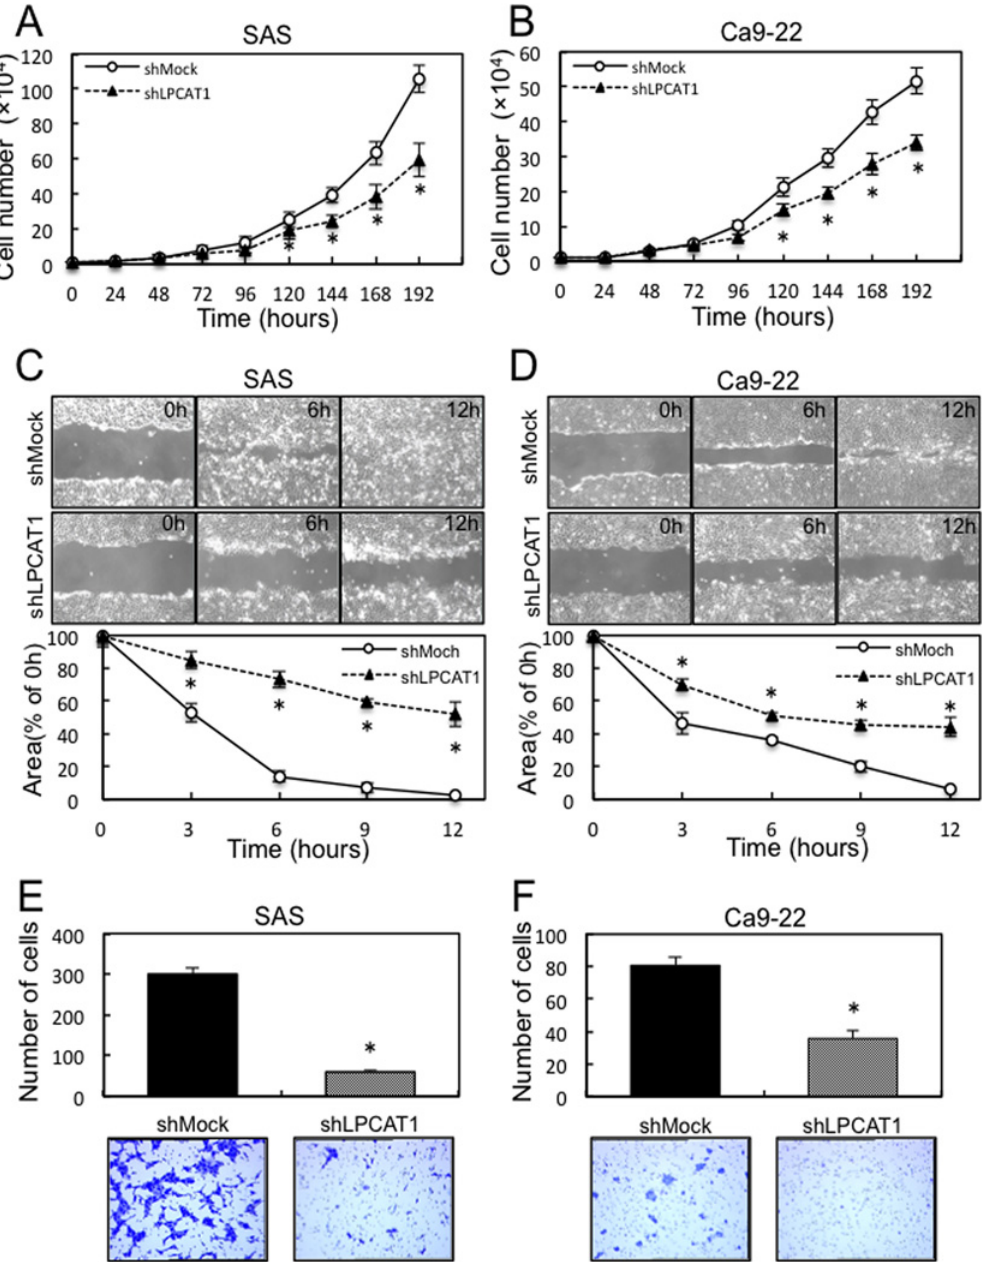
Fig 3. Effect of LPCAT1 knockdown on OSCC-derived cell lines. ( A, B ) Proliferation assay of shMock- and shLPCAT1-transfected cells (SAS- and Ca9 – 22-derived transfectants). To determine the effect of shLPCAT1 on cellular proliferation, shLPCAT1- and shMock-transfected cells were seeded in 6-cm dishes at a density of 1×10 4 viable cells/well. Both transfected cells were counted on seven consecutive days. The cellular growth of shLPCAT1-transfected cells (SAS- and Ca9 – 22- derived transfectants) is inhibited significantly compared with the shMock-transfected cells after 5 days (120 hours). The results are expressed as the mean ± SEM of values from three assays. The asterisks indicate significant ( * p < 0.05, Mann-Whitney U test) differences between the shLPCAT1- and shMock-transfected cells. ( C, D ) Migration assay of shMock- and shLPCAT1-transfected cells (SAS- and Ca9 – 22-derived transfectants). To evaluate the effect of LPCAT1 knockdown on migration, uniform wounds were made in confluent culture of the shLPCAT1- and shMock-transfected cells (SAS- and Ca9 – 22-derived transfectants) and the extent of closure was monitored visually every 3 hours for 24 hours. The mean value was calculated from data obtained from three separate chambers. The wound area was decreased significantly ( * p < 0.05, Mann-Whitney U test) in the culture of shMock- transfected cells after 12 hours, whereas a gap remained in the shLPCAT1-transfected cells. ( E, F ) Invasiveness assay of shMock- and shLPCAT1-transfected cells (SAS- and Ca9 – 22-derived transfectants). To evaluate the effect of LPCAT1 knockdown on invasiveness, we seeded 2.5×10 5 cells in the serum-free medium of a 0.8- μ m polyethylene terephthalate membrane insert in a transwell apparatus and added serum-supplemented medium in the lower chamber as a chemoattractant. After incubation at 37°C for 48 hours, cells that penetrated through the pores were fixed, stained, and counted using